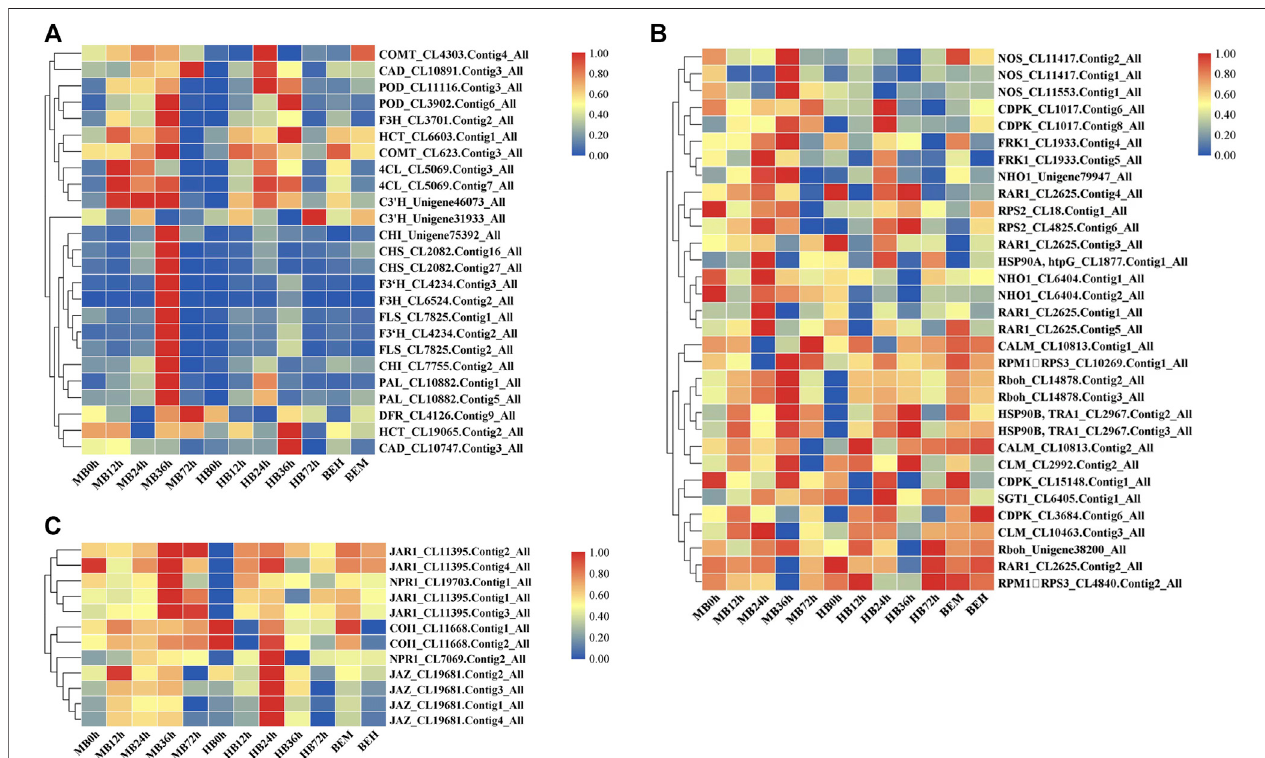
FIGURE 4 | Differential gene expression pro fi les involved in plant-pathogen interaction pathway, phenylpropanoid biosynthesis pathway, SA and JA signaling pathway during B. elliptica infection. (A) Gene expression pro fi les in plant-pathogen interaction pathway. (B) Gene expression pro fi les in phenylpropanoid biosynthesis pathway. (C) Geneexpressionpro fi lesinSAandJAsignalingpathway.MBrepresentsplantswerepre-treatmentwithmelatoninandtheninoculatedwith B.elliptica ;HB represents plants were pre-treatment with Milli-Q water [ethanol/water (v/v) D 1/10,000], and then inoculated with B. elliptica . BEM represents plants were inoculated with B. elliptica for 36 h and then treated with 100 ml melatonin (2 mM/L) for 36 h; BEH represents plants were inoculated with B. elliptica for 36 h and then treated with 100 ml Milli-Q water [ethanol/water (v/v) D 1/10,000] for 36